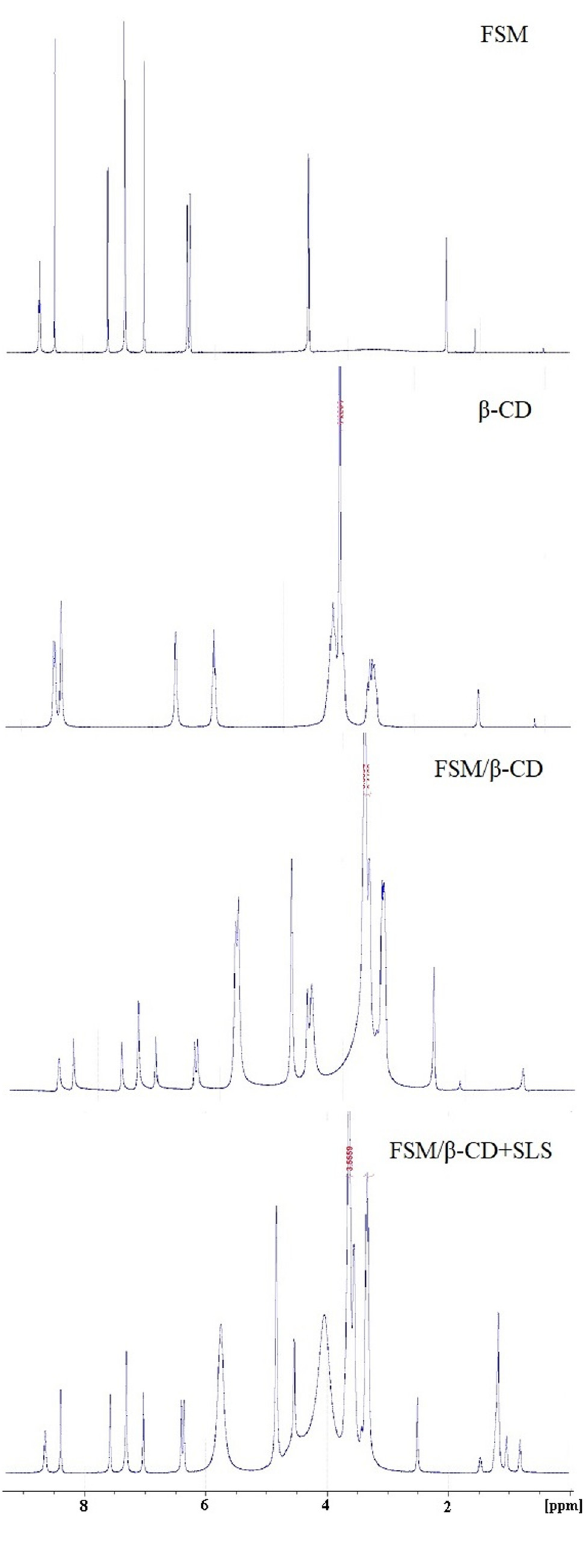
Figure 5: Comparative 1 H NMR spectra of